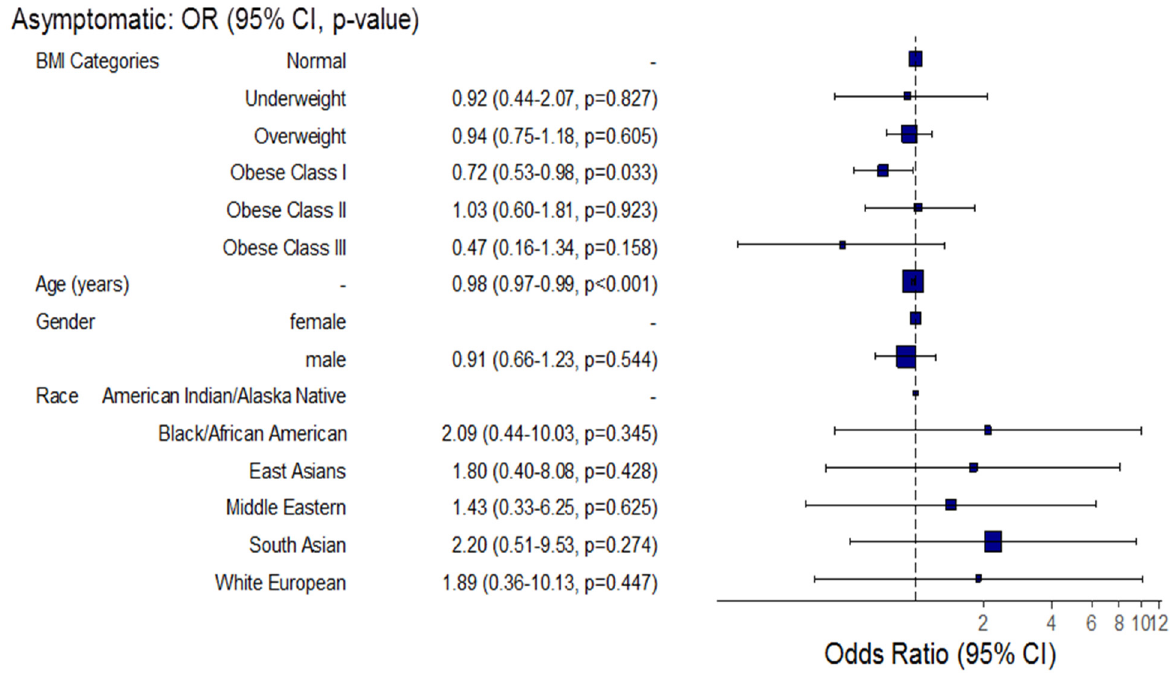
Figure 5. Forest plot for the association between BMI and asymptomatic hospitalized COVID-19 patients.